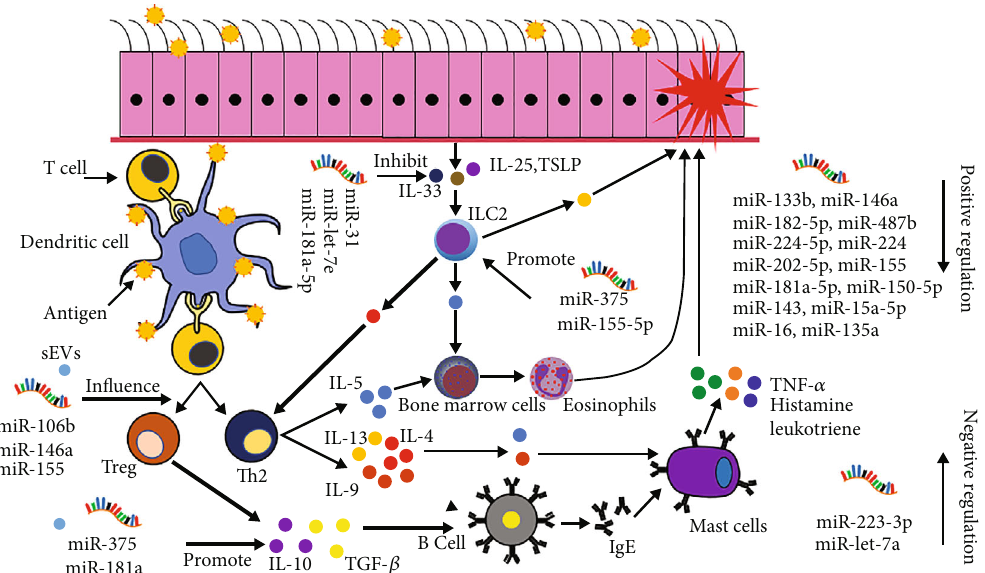
Figure 1: Regulation of EVs and miRNAs in allergic